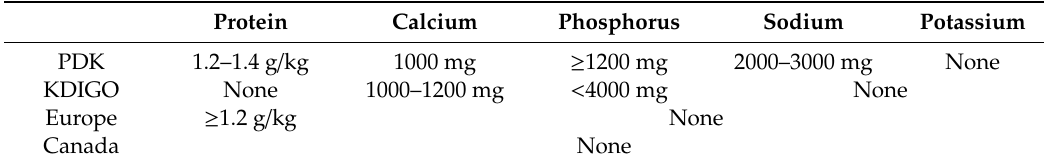
Table 1. Daily macro- and micro-nutrient intake.